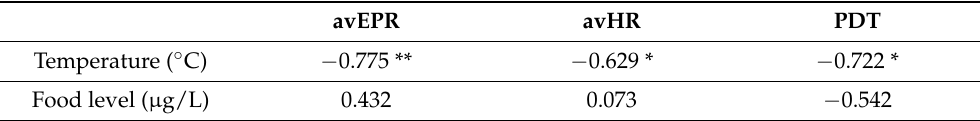
Table 2. Pearson correlations between Acartia bifilosa population recruitment (avEPR, HR, and PDT) and environmental factors (temperature and food level) in the Jiaozhou Bay. avEPR avHR